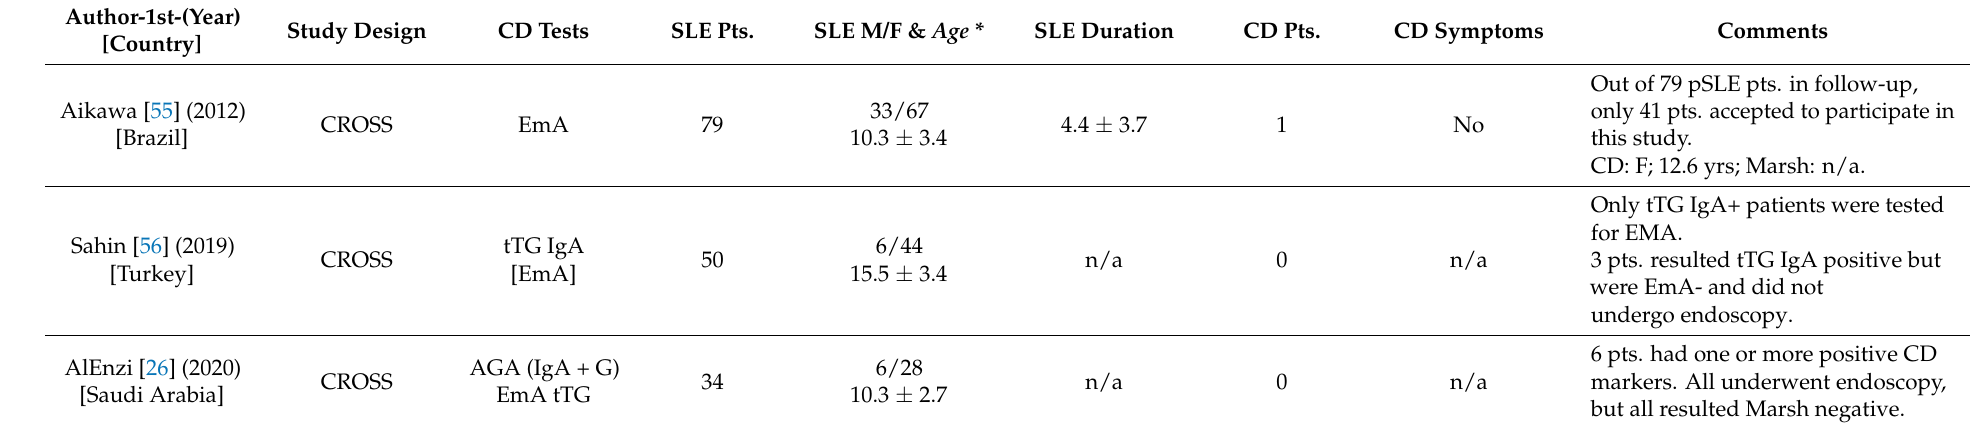
Table 2. Clinical studies assessing CD in children affected with